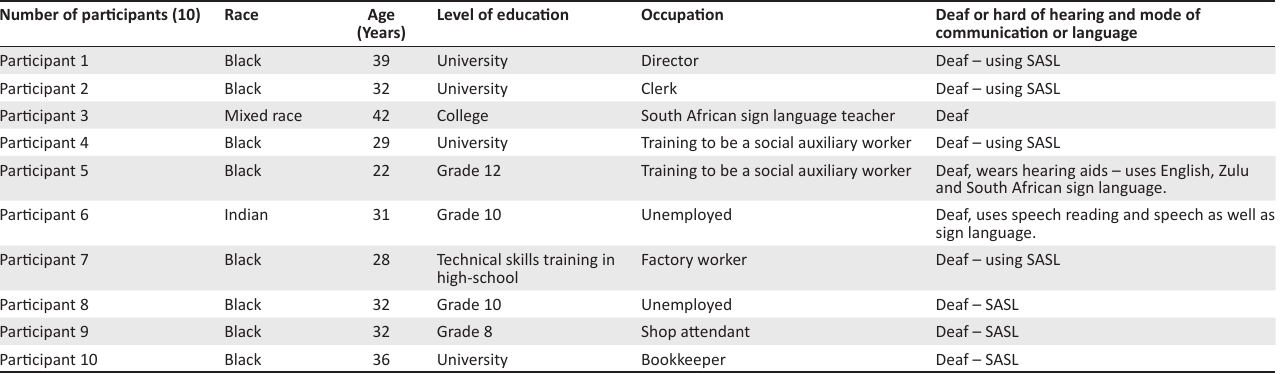
TABLE 1: Participant profiles. Number of participants (10)